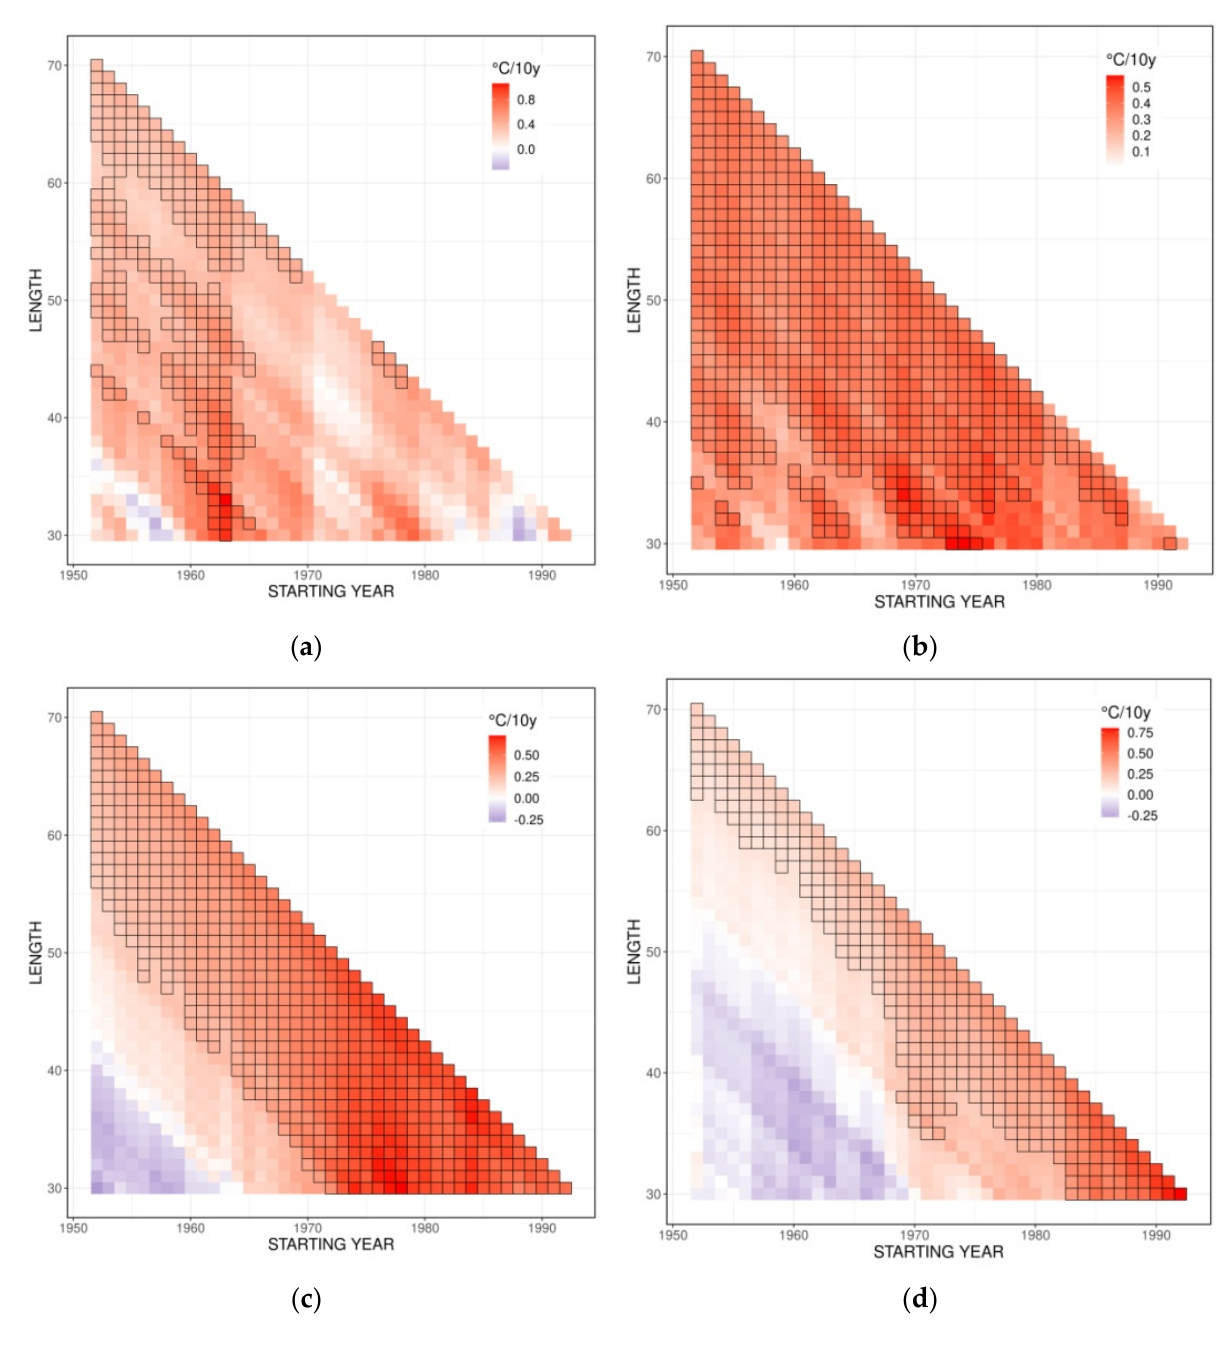
Figure 6. Trend coefficients (those significant at the 0.05 level tested with MK test are outlined) of average seasonal air temperature in Poland for a given start year and length of the analyzed period ( a ) DJF, ( b ) MAM, ( c ) JJA, and ( d ) SON. Summer, a season when there was a significant shift from negative trends’ coefficients for periods beginning in the 1950s, and lasting up to 40 years to highly pronounced positive trends with the values of coefficients exceeding 0.7 ◦ C/decade for periods starting in the late 1970s with lengths up to 40 years. What is apparent is the fact that for longer time series starting in the 1950s, only those of approximately 60 years in length tend to be statistically significant. In contrast, since the mid-1970s, air temperature variability exhibited a positive statistically significant trend for all possible time series lengths. The last 30-year normal period trend coefficient (1991–2020) is 0.52 ◦ C/decade, nearly twice as high as the 71-year trend (1951–2021) at a level of 0.29 ◦